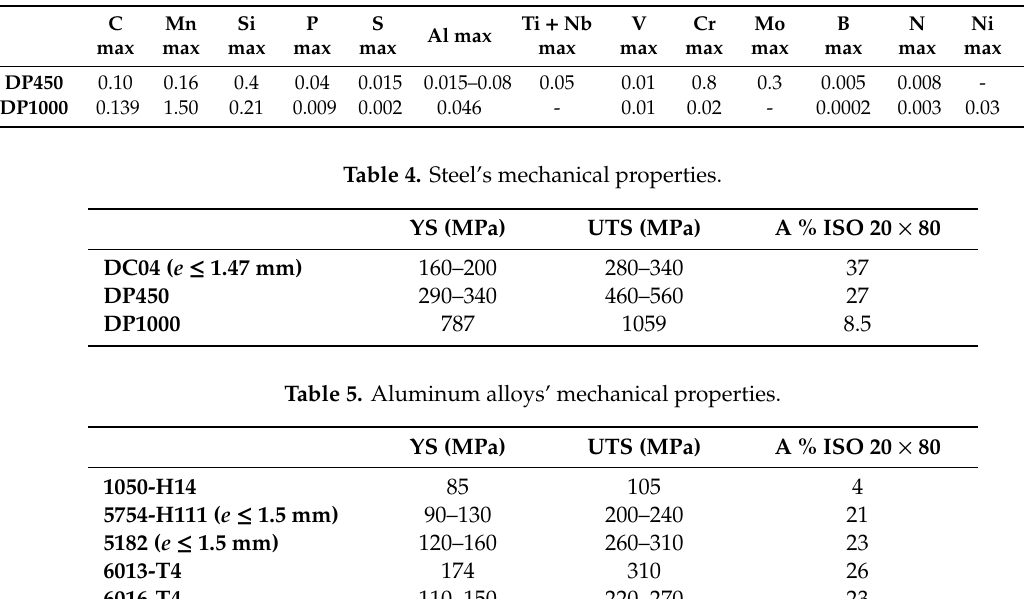
Table 3. DP steels chemical compositions (%at.).